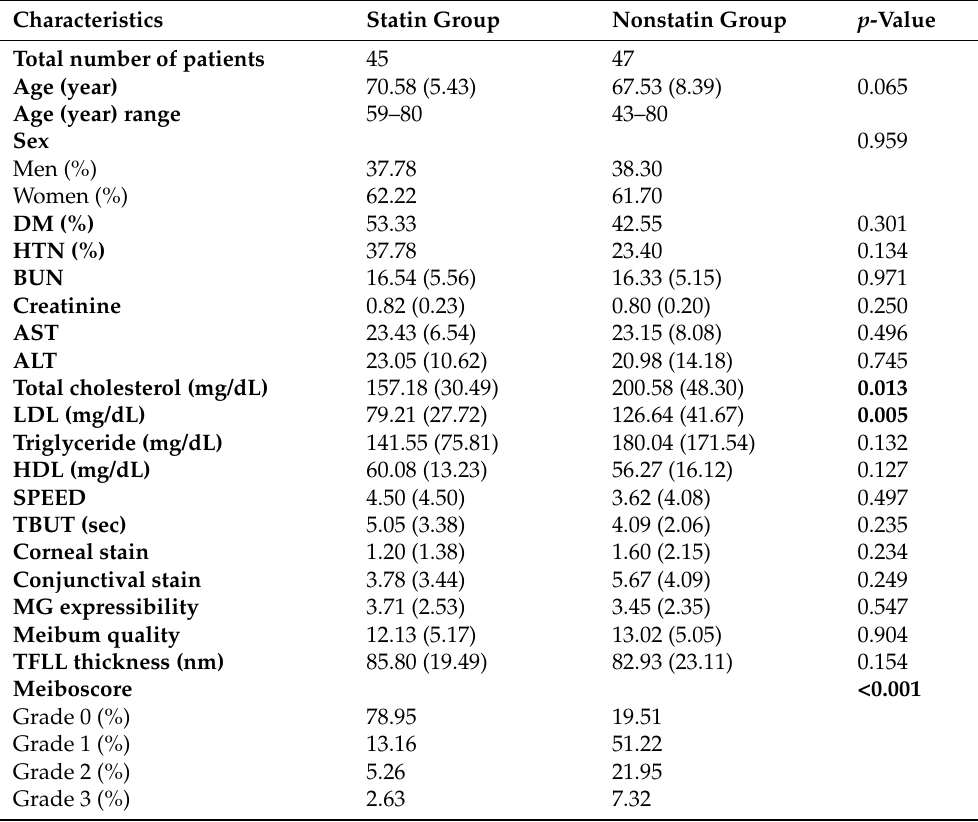
Table 1. Demographics and clinical characteristics of